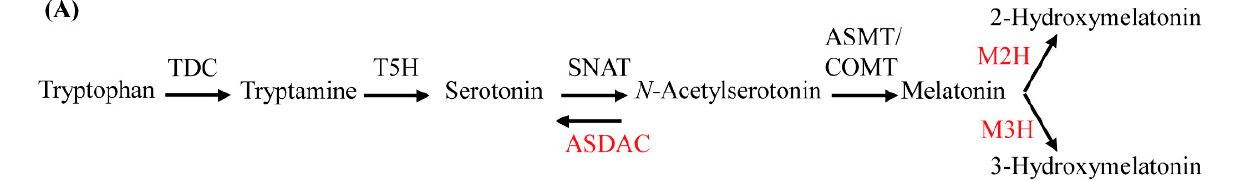
Figure 2. ( A ) Pathways of melatonin biosynthesis and catabolism. ( B ) Melatonin levels in rice seed- lings treated with brassinosteroid in the absence of cadmium treatment. ( C ) Expression levels of transcripts encoding melatonin biosynthetic and catabolic genes. Seven-day-old rice seedlings were treated rhizosperically with various concentrations of epibrassinolide (BR) for quantification of mel- atonin or with 1 μ M epibrassinolide (BR) for qRT-PCR for 24 h. The upper parts of leaves and stems were collected for HPLC quantification of melatonin and qRT-PCR analysis of various genes in- volved in melatonin synthesis and catabolism. The primer sequences were previously described [20]. C, water containing 0.1% ethanol. Asterisks (*) denote significant differences ( p < 0.05; ANOVA, followed by Tukey’s HSD post hoc tests). C, water containing 0.1% ethanol; BR, epibrassinolide; TDC1 , tryptophan decarboxylase 1 (AK069031); TDC2 (AK103253); TDC3 (Os08g0140500); T5H , tryptamine 5-hydroxylase (AK071599); SNAT1 , serotonin N -acetyltransferase 1 (AK059369); SNAT2 (AK068156); COMT , caffeic acid O -methyltransferase (AK064768); ASMT1 , N -acetylserotonin O-me- thyltransferase (AK072740); ASDAC , N -acetylserotonin deacetylase (AK072557); M3H , melatonin 3- hydroxylase (AK067086); M2H , melatonin 2-hydroxylase (AK119413); UBQ5 , ubiquitin 5 (Os03g13170). 3.3. Melatonin Biosynthesis Was Severely Compromised in Transgenic Rice Plants with Various RNAis Downregulating the BR Biosynthesis-Related Genes DWARF4, DWARF11, and RAVL1 To investigate whether a decrease in BR leads to a reduction of melatonin biosynthe- sis, three BR biosynthesis-related genes were downregulated using an RNAi strategy (Fig- ure 3). The two BR biosynthetic genes, DWARF4 and DWARF11 , which catalyze C-22 hy- droxylation, the rate-limiting step of BR biosynthesis, have redundant functions, but show a 37% amino-acid identity [25]. The third gene, RAV-like1 ( RAVL1 ), is a transcription factor that binds BR biosynthetic genes, such as DWARF11 and ebisu dwarf ( D2 ), as well as the BR receptor BRI1 , leading to increased BR synthesis [26,27]. All three RNAi transgenic rice